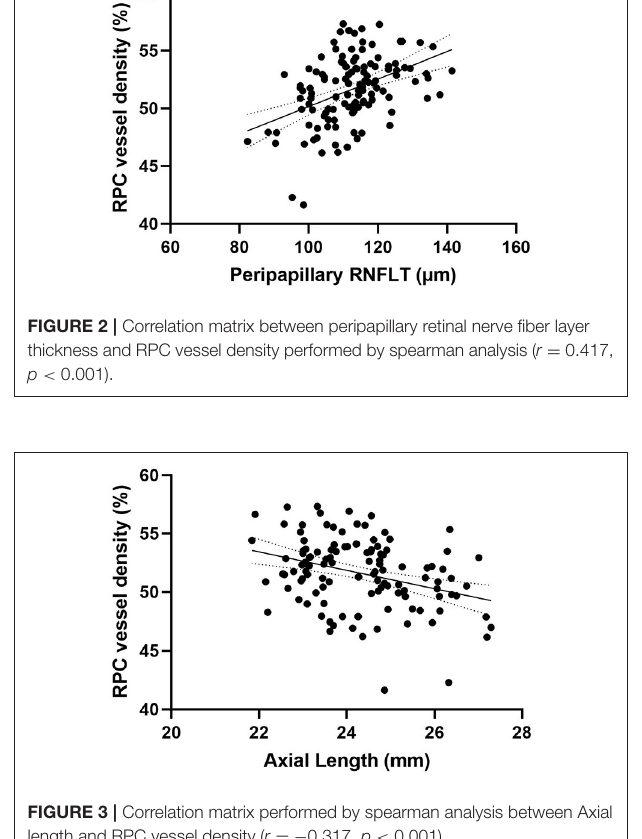
vessel density, while FSQ score ( r = − 0.214, p = 0.019) ( Figure 4 )